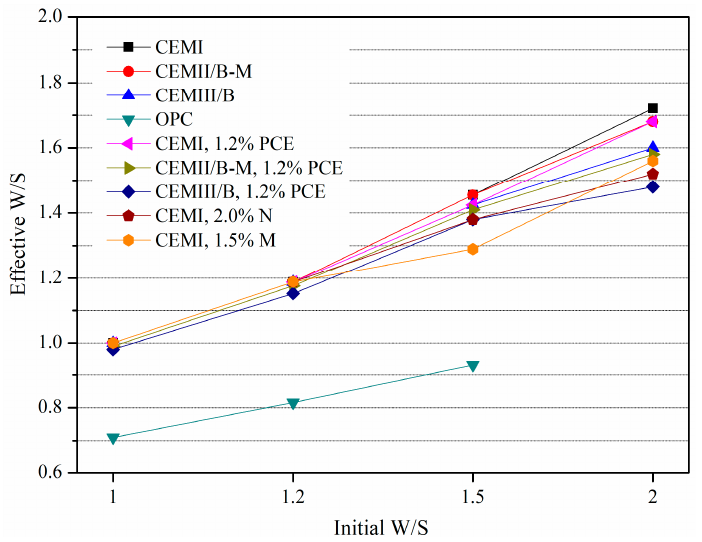
Figure 10. Effect of SP, cement type and initial W/S on the effective W/S of fresh SMCG slurry.